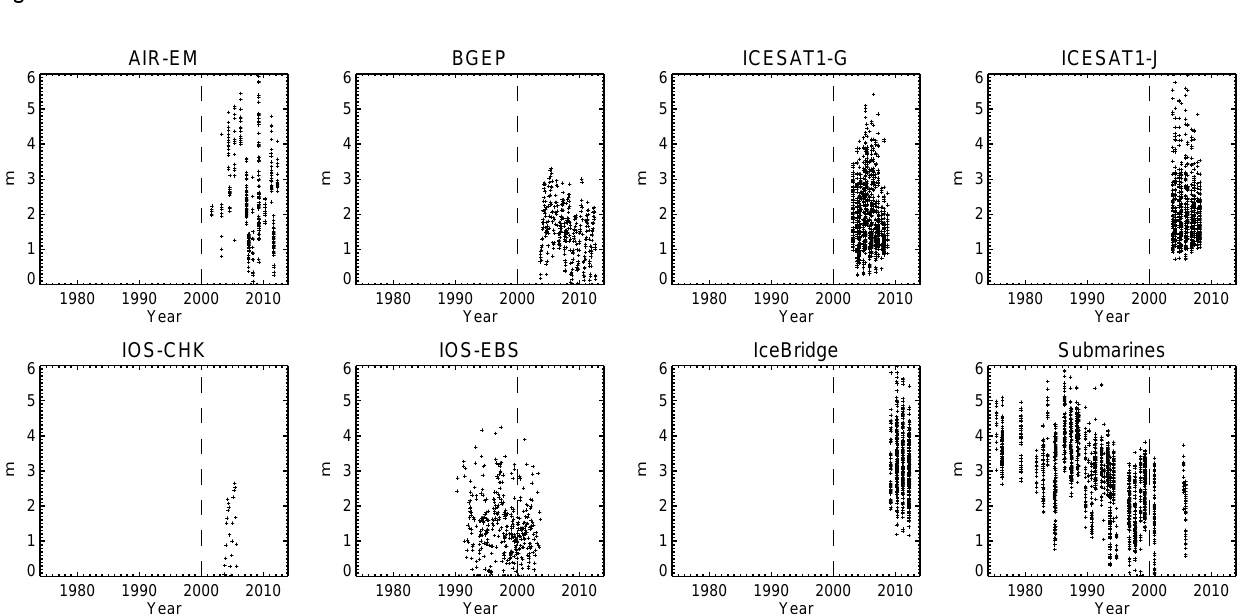
Figure 2. Times and ice thickness of the observations from different data sources. The primary focus is on the years after 2000 (dashed line).